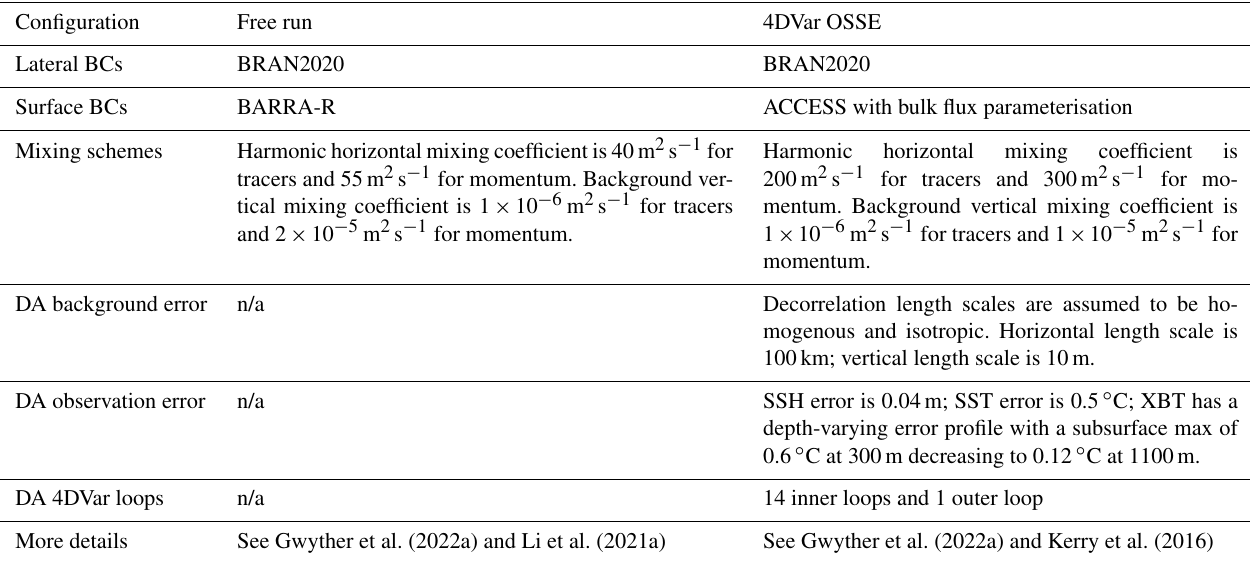
Table C1. Key differences in model configuration and boundary conditions (BCs) are shown between the free-running Ref state and the 4DVar OSSEs. Further details are given in Gwyther et al. (2022a) and references therein. n/a – not applicable